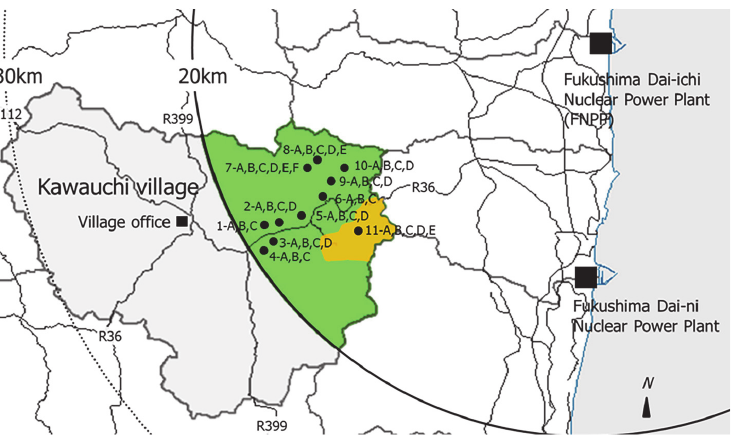
Fig 2. Location of sampling points, Kawauchi Village, Fukushima Prefecture. Closed circles ( ● ) are sampling points.